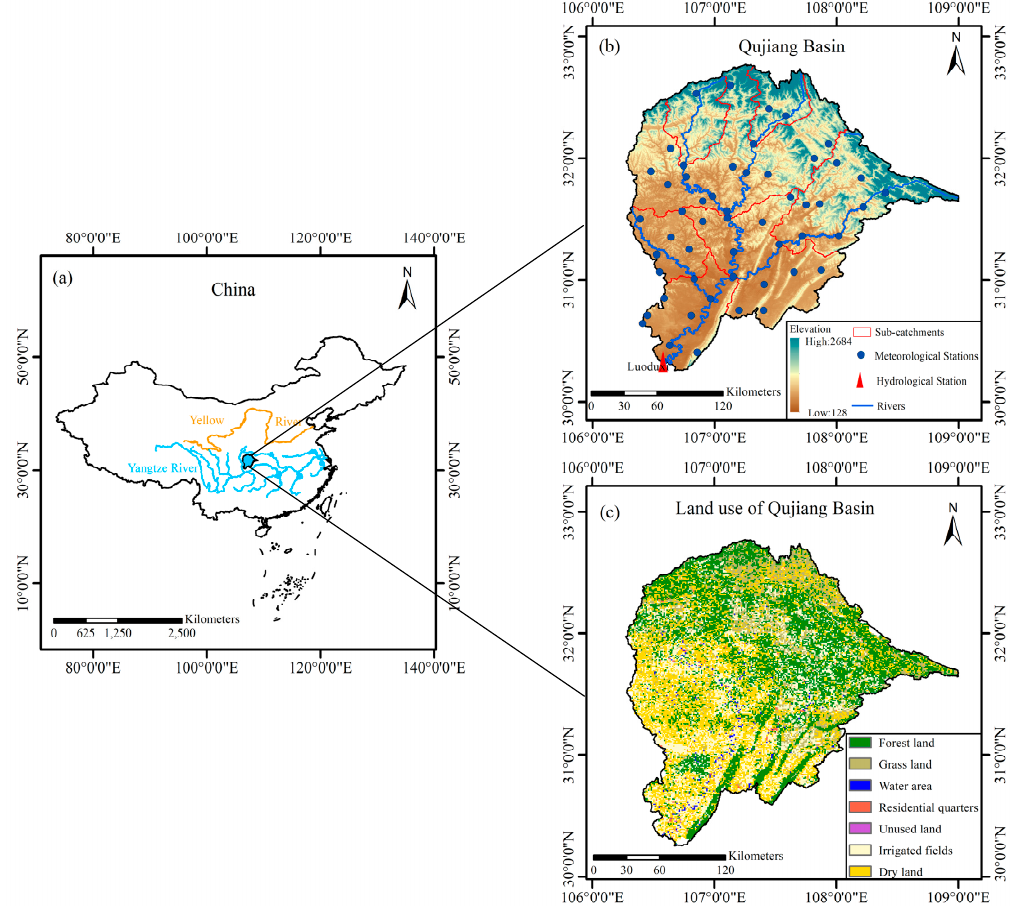
Figure 1. Topography ( b ) and land use ( c ) in 2010 of the Qujiang catchment in China ( a ): ( a ) the location of the Qujiang catchment (blue-shaded); ( b ) river networks (blue lines) and sub-catchments (circled by red lines), as well as meteorological stations (blue dots) and a hydrological station (red triangle) at the outlet of the Qujiang catchment.